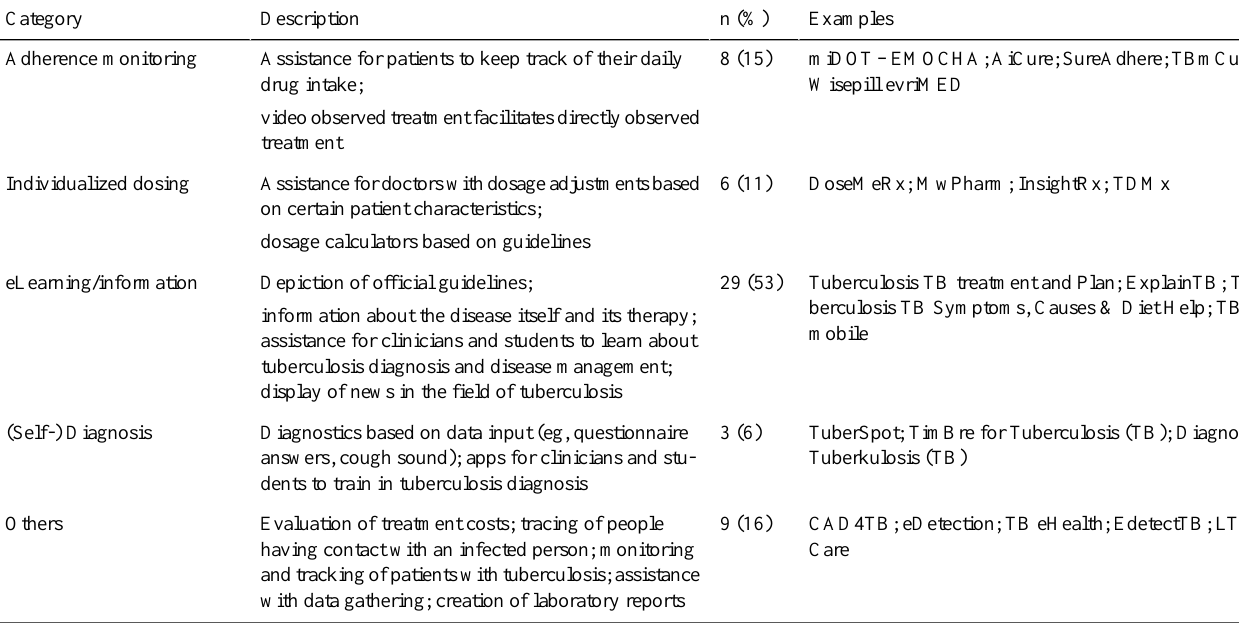
Table 1. Categorization of the included mHealth apps